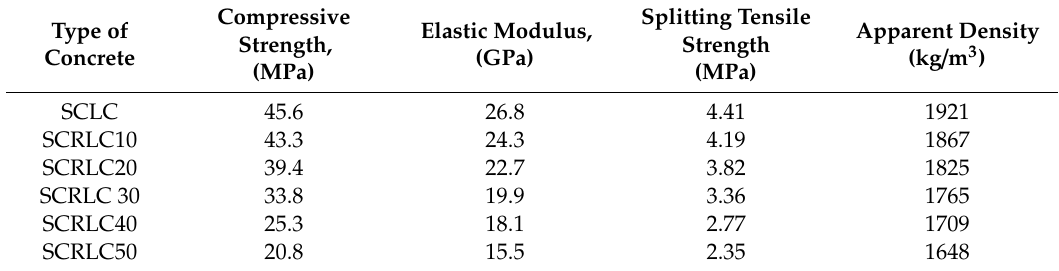
Table 5. Properties of SCRLC.